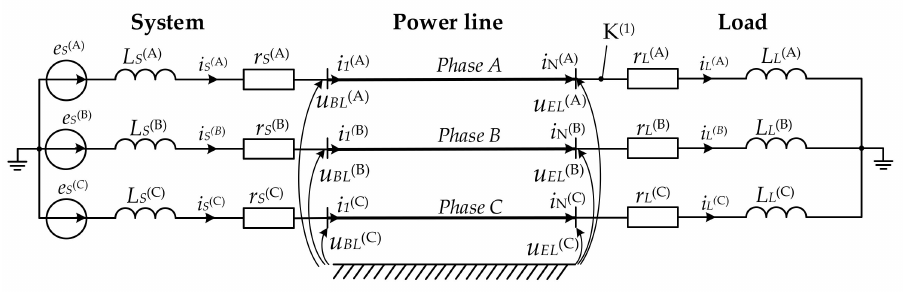
Figure 2. Computing diagram of an electric network power supply